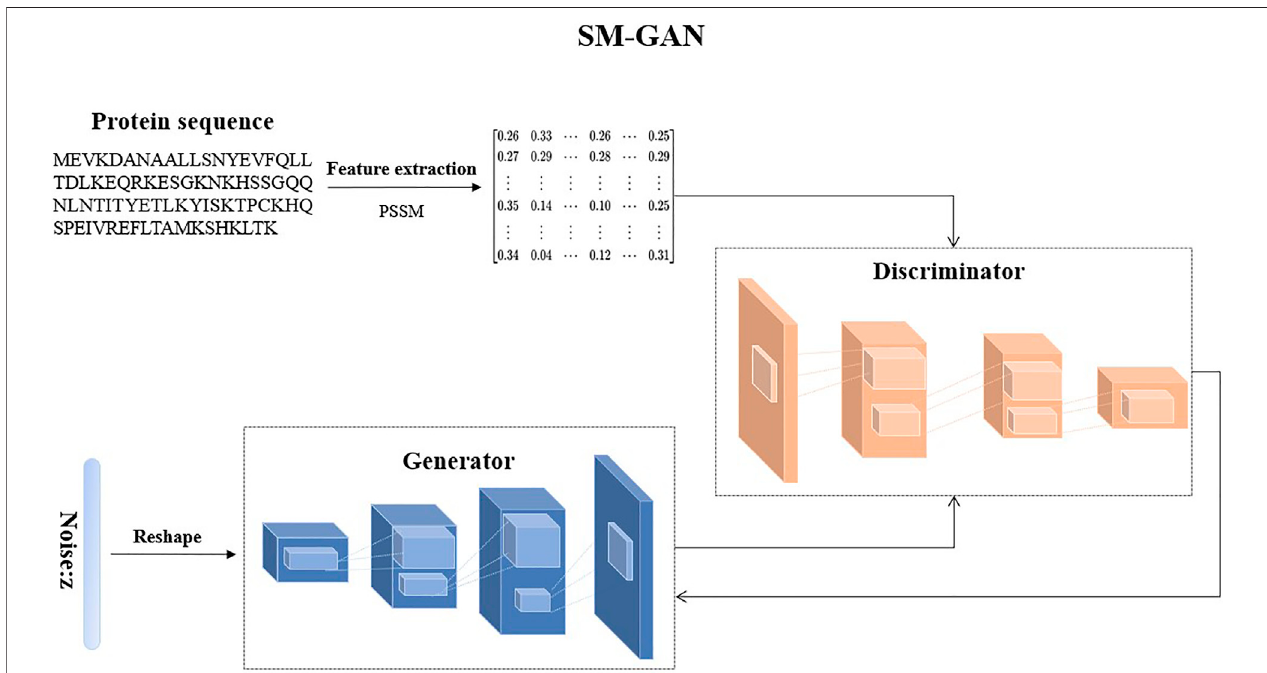
FIGURE 2 | An illustration of